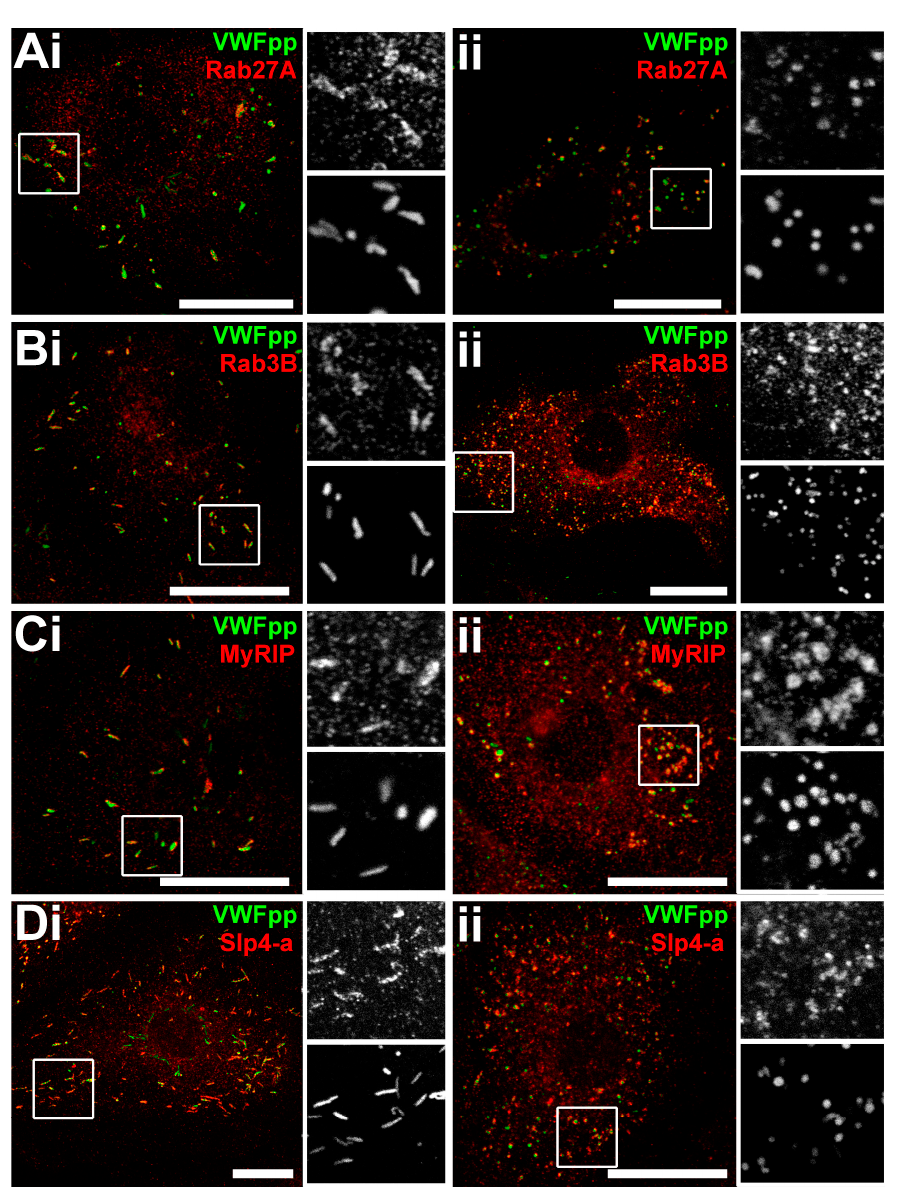
Figure 2. WPBs in HCMEC C and HCMEC D recruit endogenous Rab27A, Rab3B, MyRIP and Slp4 a. Confocal fluorescence images of HCMEC C ( Ai – Di ) and HCMEC D ( Aii – Dii ) immunolabeled for endogenous VWFpp (green) and in red; Rab27A ( A ), Rab3B ( B ), MyRIP ( C ) or Slp4-a ( D ), respectively. In each case, regions indicated by the white boxes are shown in grayscale on an expanded scale with VWFpp labelling in lower panels. Images are representative of 3 donors in each case. Scale bars are 20 µm. HCMEC; human cardiac microvascular endothelial cells ( C ; control, D ; dilated cardiomyopathy). VWFpp; von Willebrand factor propeptide. MYRIP; myosin rab interacting protein. Slp4a; synaptotagmin-like protein